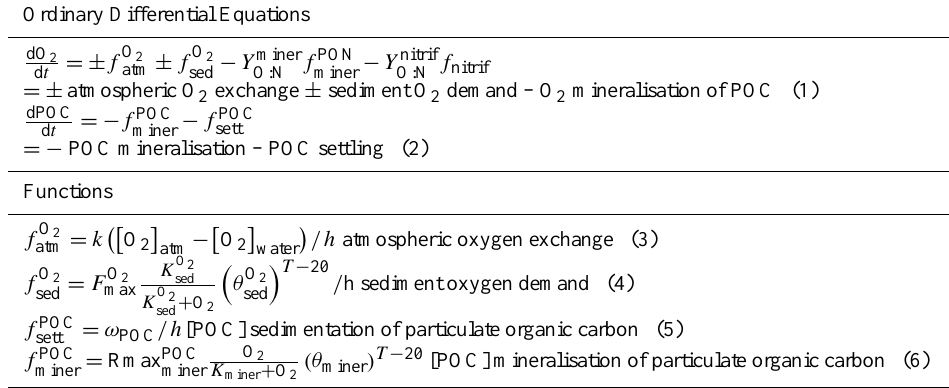
Table 1. Equations used to parameterize the processes represented in the biogeochemical model. Ordinary Differential